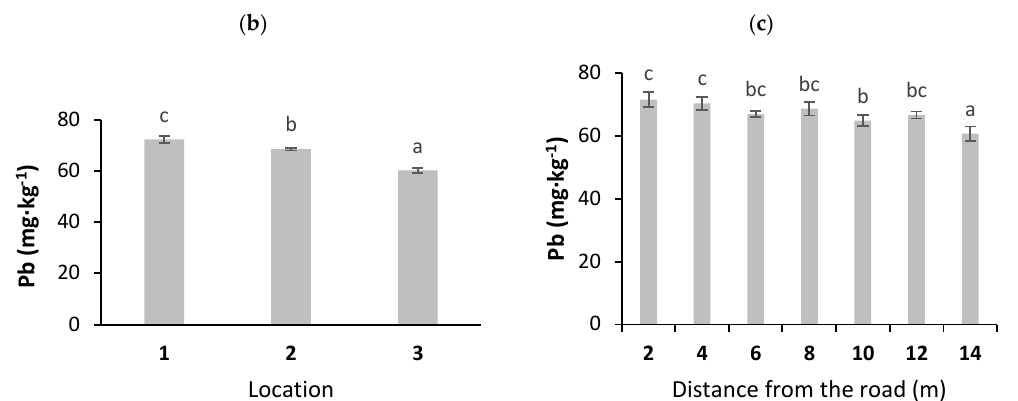
Figure 3. Lead concentrations in moss ( P. schreberi ): ( a ) distance from the road at sampling location, ( b ) average Pb content at di ff erent locations, and ( c ) Pb content at di ff erent distances from the road (average values from three locations) ( n = 5, ± standard deviation). Di ff erent letters above bars representing lead concentrations for di ff erent locations or for di ff erent distances from the road indicate that they differed significantly (Tukey’s test, p < 0.01).